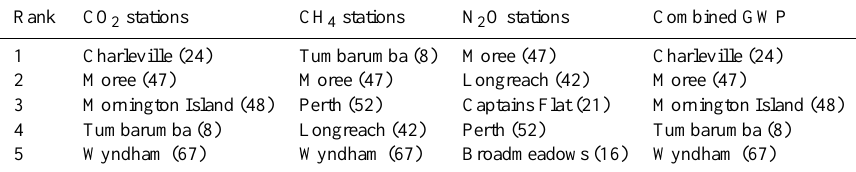
Table 4. Ranking for new stations added to the base network in terms of their ability to reduce the uncertainties on CO 2 , CH 4 and N 2 O flux estimates individually and in combination (using GWP weights in cost function). The station number is provided in